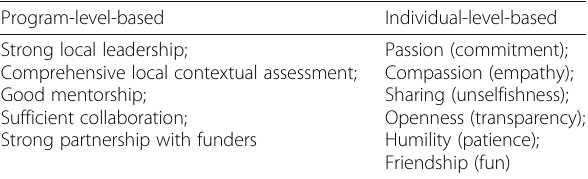
Table 2 Common key elements learnt from the